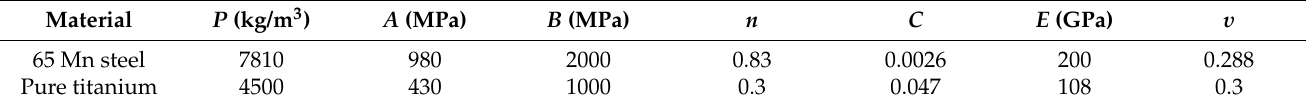
Table 1. Mechanical parameters of 65 manganese steel and TA2 titanium alloy.